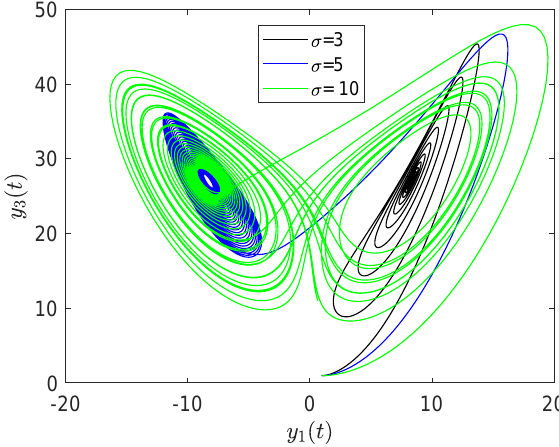
Figure 21. Phase portraits of y 1 and y 3 when varying σ